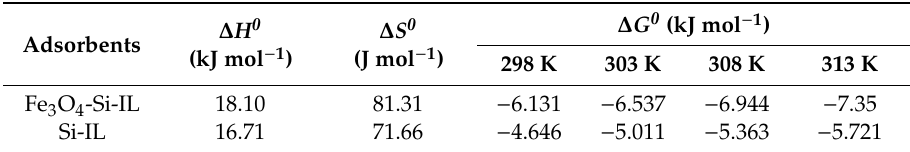
Table 3. Thermodynamic parameters of Fe 3 O 4 -Si-IL and Si-IL for removal of CR from aqueous solution at di ff erent